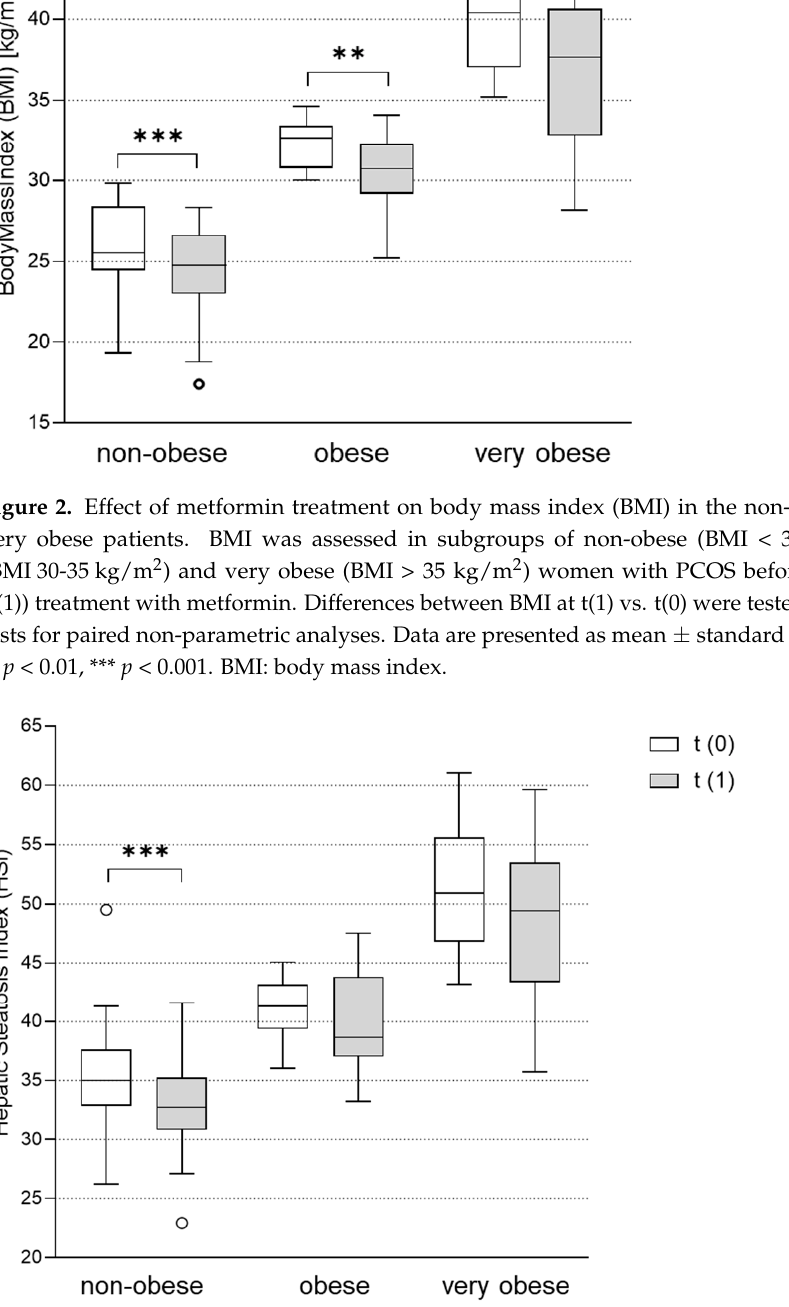
Figure 3. Effect of metformin treatment on hepatic steatosis index (HSI) in non-obese, obese and very obese patients. The HSI was assessed in subgroups of non-obese (BMI < 30 kg/m 2 ), obese (BMI 30-35 kg/m 2 ) and very obese (BMI > 35 kg/m 2 ) women with PCOS before (t(0)) and after (t(1)) treatment with metformin. Differences between the HSI at t(1) vs. t(0) were tested using Wilcoxon tests for paired non-parametric analyses. Data are presented as mean ± standard error of the mean. *** p < 0.001. HSI: hepatic steatosis index.